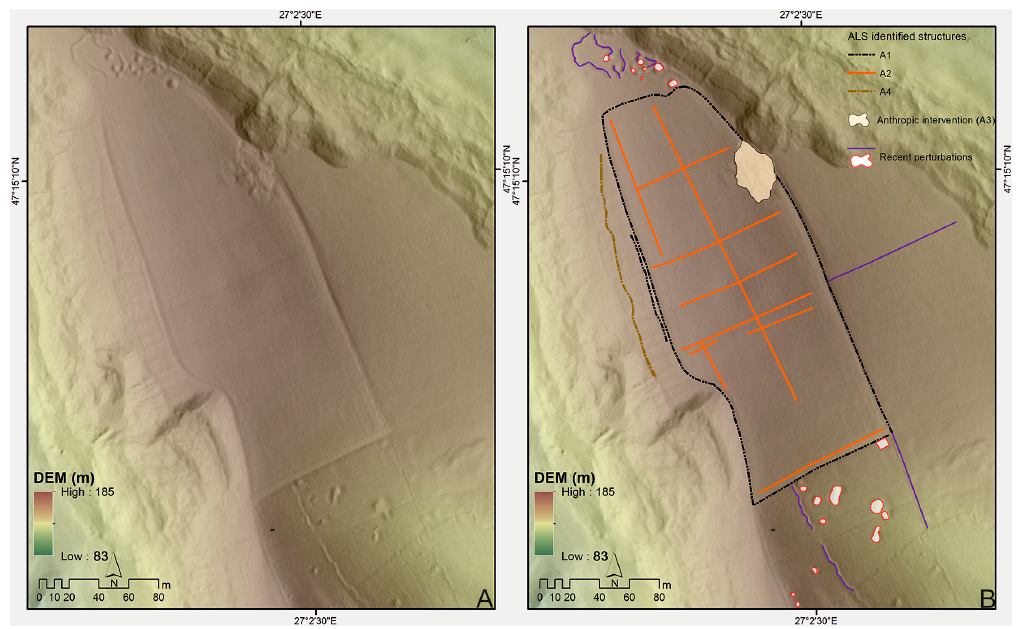
Figure 7. Identified structures in the ALS data: ( A ) ALS hypsometric map (hill shade superimposed by DEM); ( B ) The identified features.